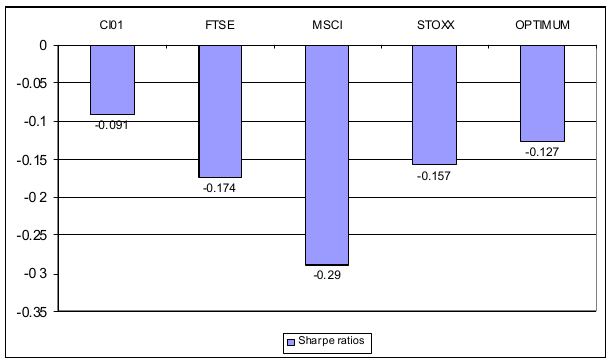
Figure 6: Sharpe ratios